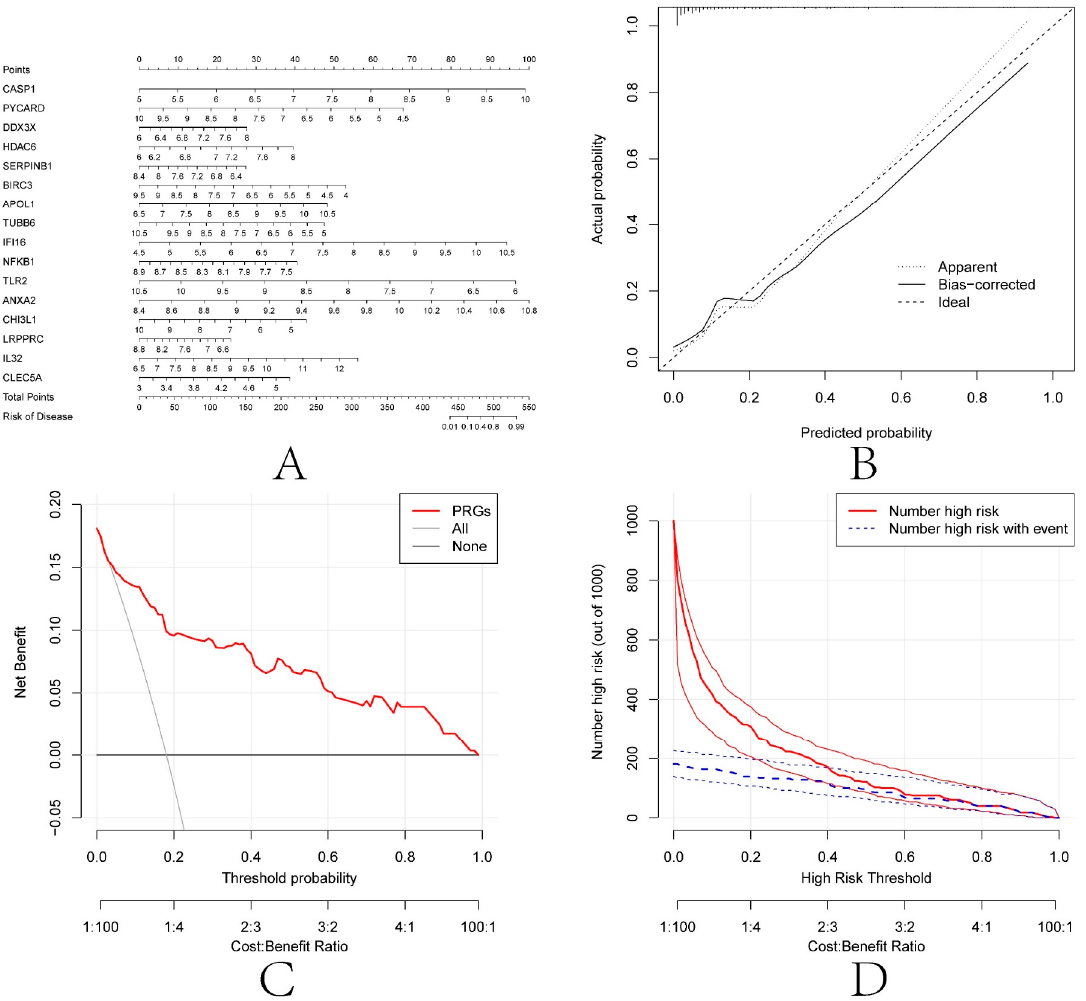
Figure 9. Construction of the nomogram model. ( A ) Construction of the nomogram model based on the selected PRGs (CASP1, PYCARD, DDX3X, HDAC6, SERPINB1, BIRC3, APOL1, TUBB6, IFI16, NFKB1, TLR2, ANXA2, CHI3L1, LRPPRC, IL32 and CLEC5A). ( B ) Calibration curve